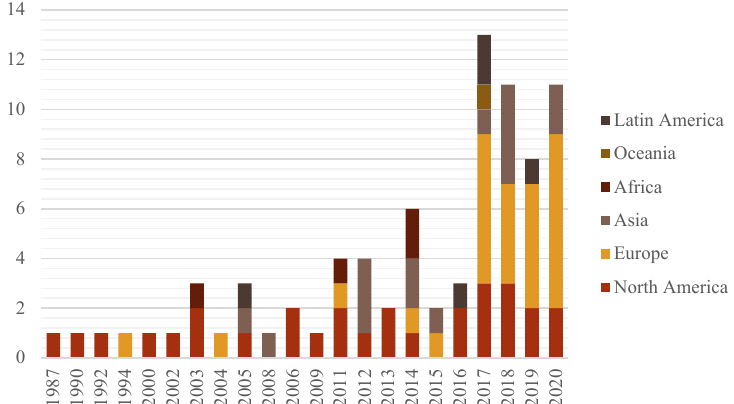
Fig. 2: Matching the place and time of the case studies